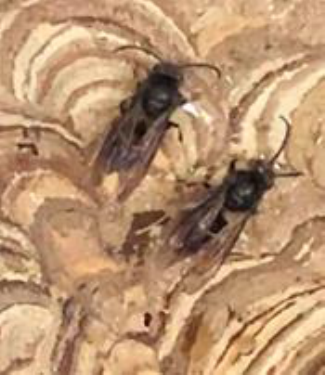
Figure 11. Vespa velutina male hornets in the nest.